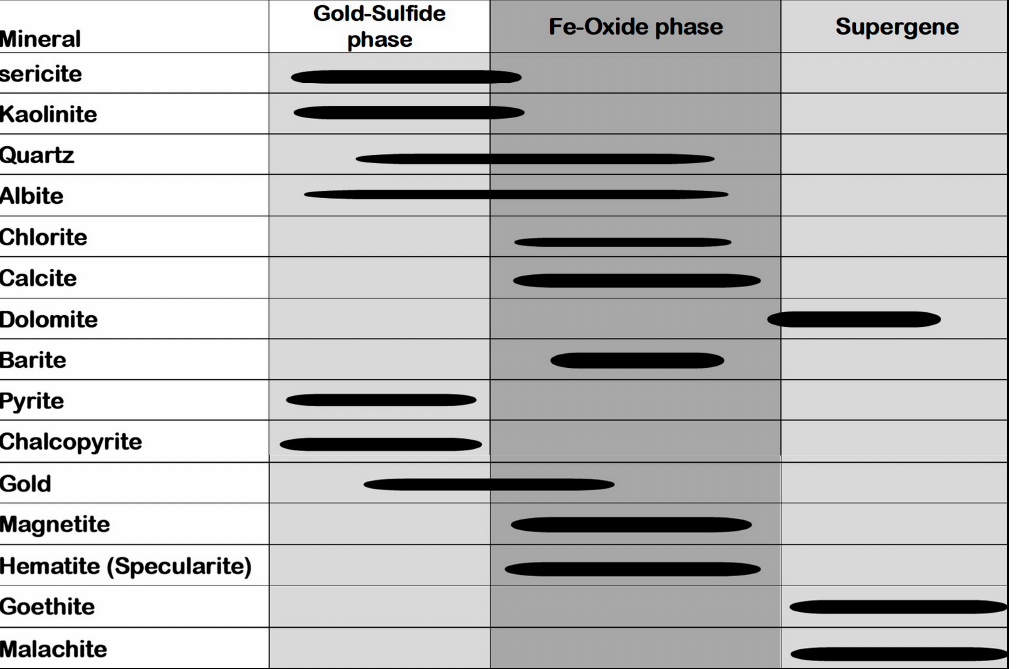
Figure 10. Paragenetic sequence of alteration, sulfide, Fe-oxide, and supergene minerals, as defined by mineral assemblages.